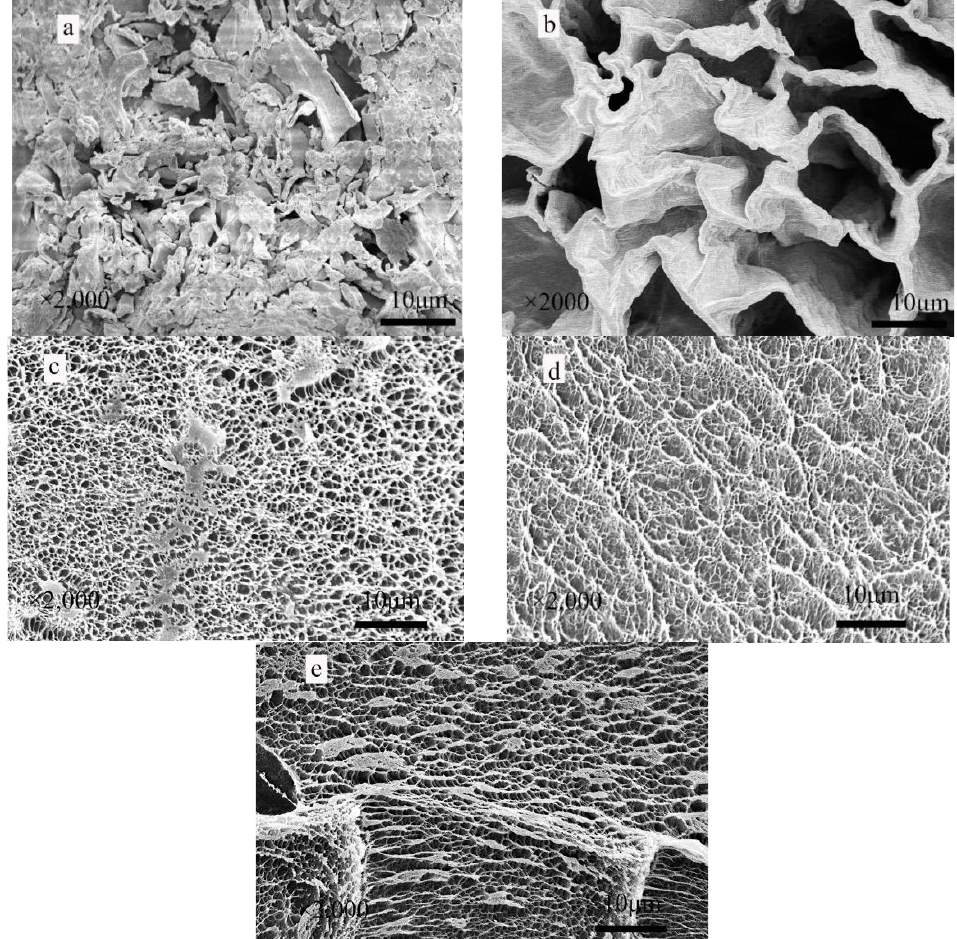
Figure 4. SEM images of RIR ( a ), RIR-NaOH ( b ), RIR/PAM 3 ( c ), RIR/PAA 4 ( d ) and RIR/AA-co-AM ( e ).